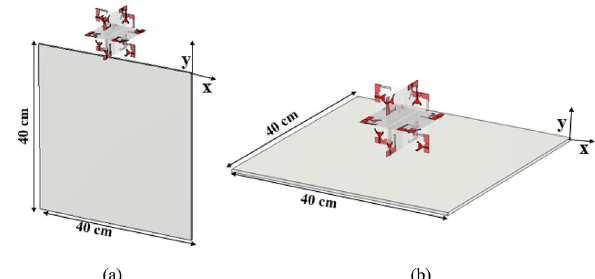
Figure 18. Housing effect: ( a ) case-1 and ( b ) case-2.